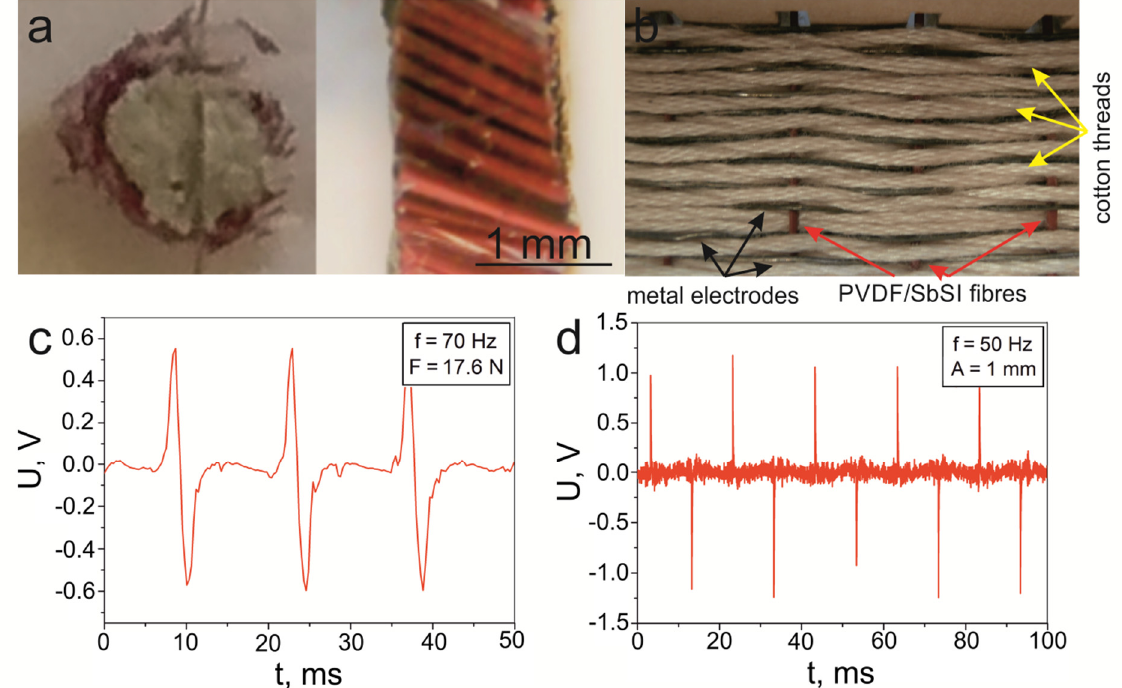
Figure 16. ( a ) Sample photograph consisting of around 300 PVDF/SbSI fibres that are arranged perpendicular to the electrodes (top and side views), ( b ) A textile fabric composed of interlacing fibres, metal wires, and cotton threads. ( c ) Voltage signal over time for the sample presented in Figure 16a under an impact ( f = 70 Hz, F = 17.6 N, T = 293 K), ( d ) Voltage signal for the textile of ( b ) under a vibrational excitation ( f = 50 Hz, A = 1 mm).